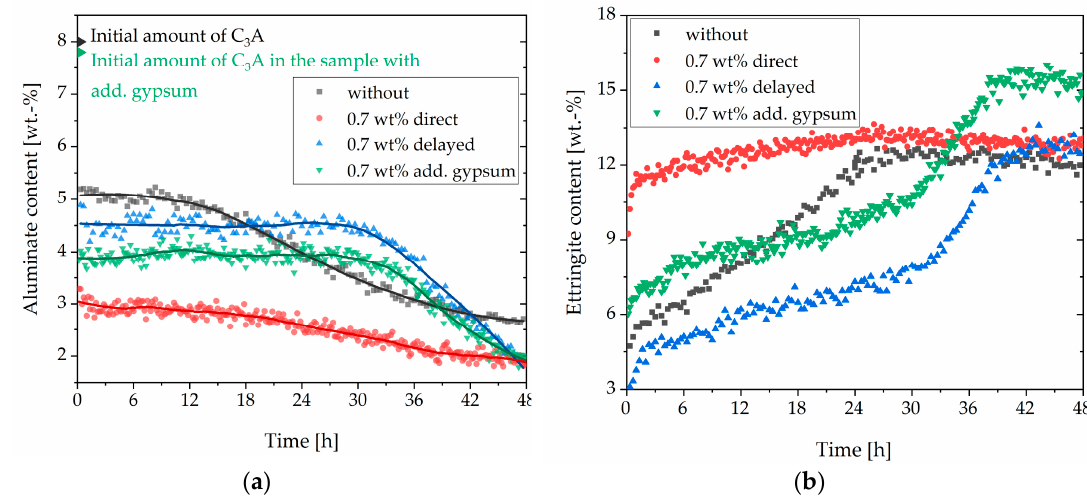
Figure 10. Summary of the ( a ) aluminate and ( b ) ettringite content of the samples without SP, with direct addition of 0.7 wt% of SP, with a delayed addition of 0.7 wt% of SP, with 2 wt% of additional gypsum, and direct addition of 0.7 wt% of SP